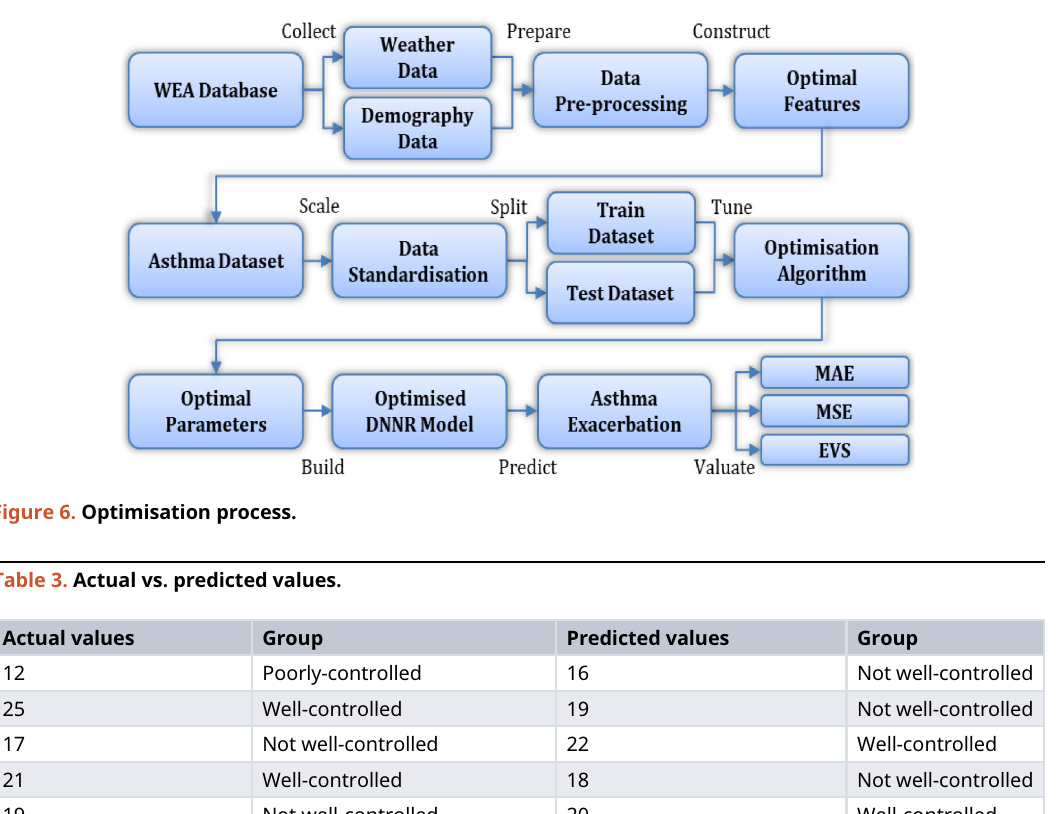
Figure 5. Optimisation algorithm.